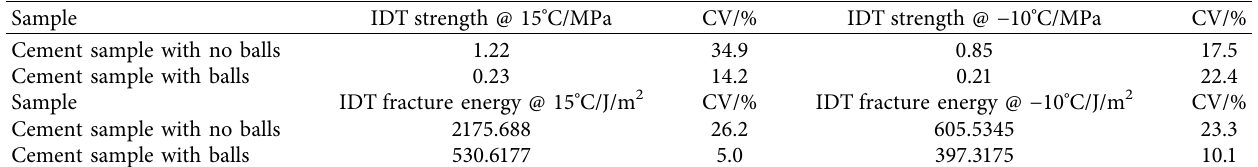
Table 5: IDT strength and fracture energy of cement